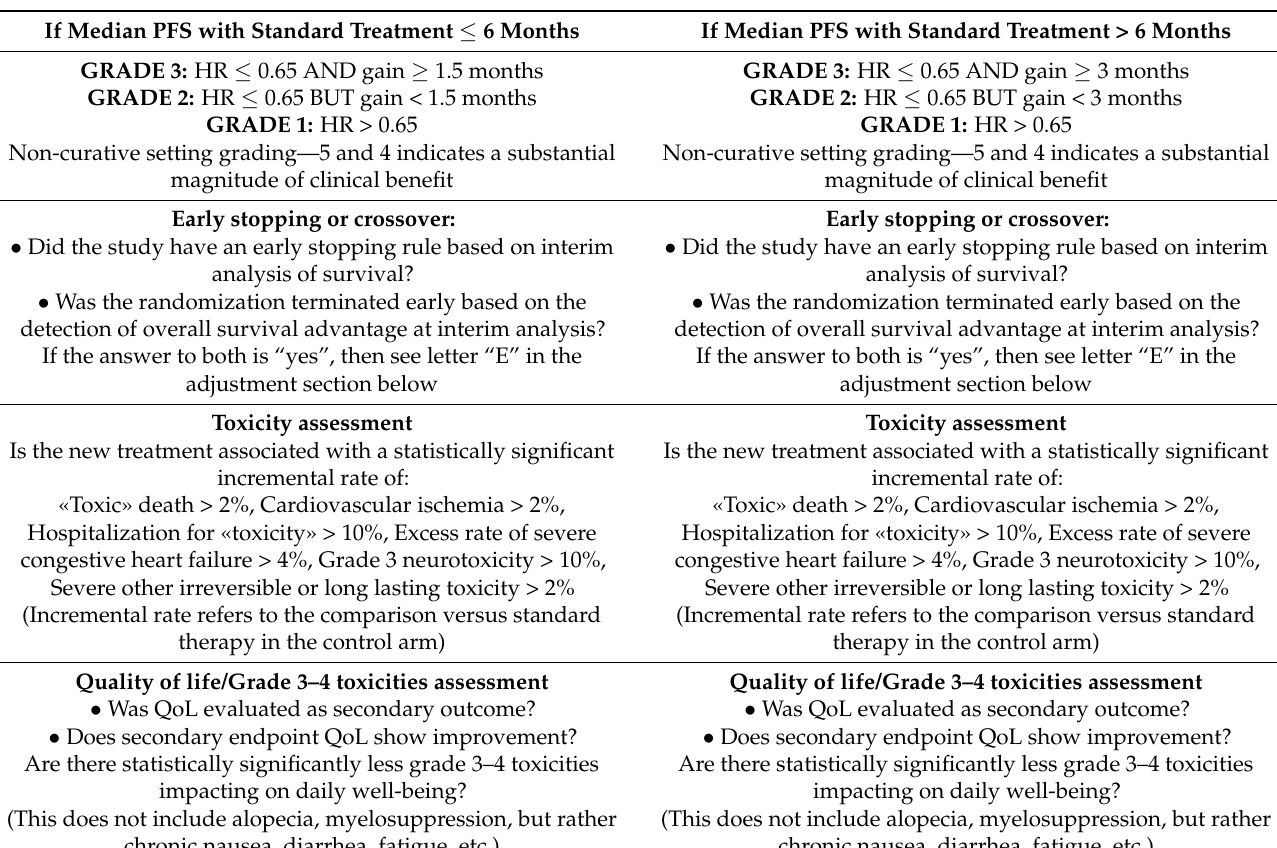
Table 3. ESMO-MCBS v1.1 evaluation form 2B. For therapies that are not likely to be curative with primary endpoint of